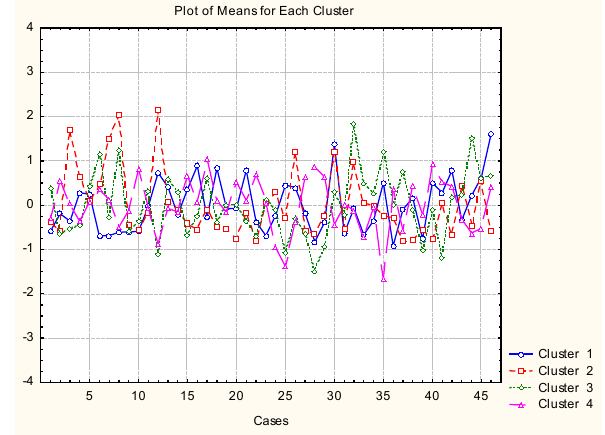
Figure 1: Plot of means for each identified cluster of clinical parameters for the whole group of